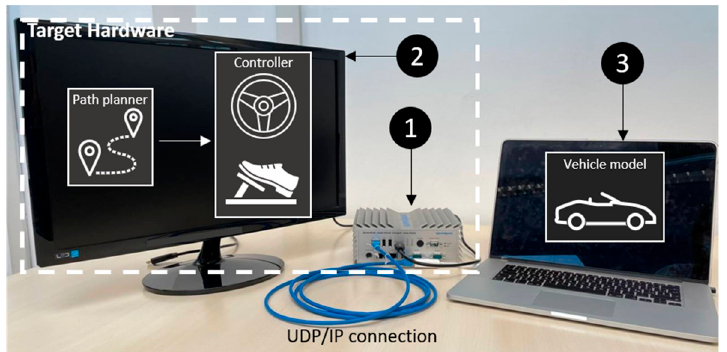
Figure 6. PIL test architecture setup, exploiting UDP/IP connection between host PC and real-time target hardware: (1) Speedgoat Baseline Real-Time target machine; (2) target PC monitor; (3) host PC.